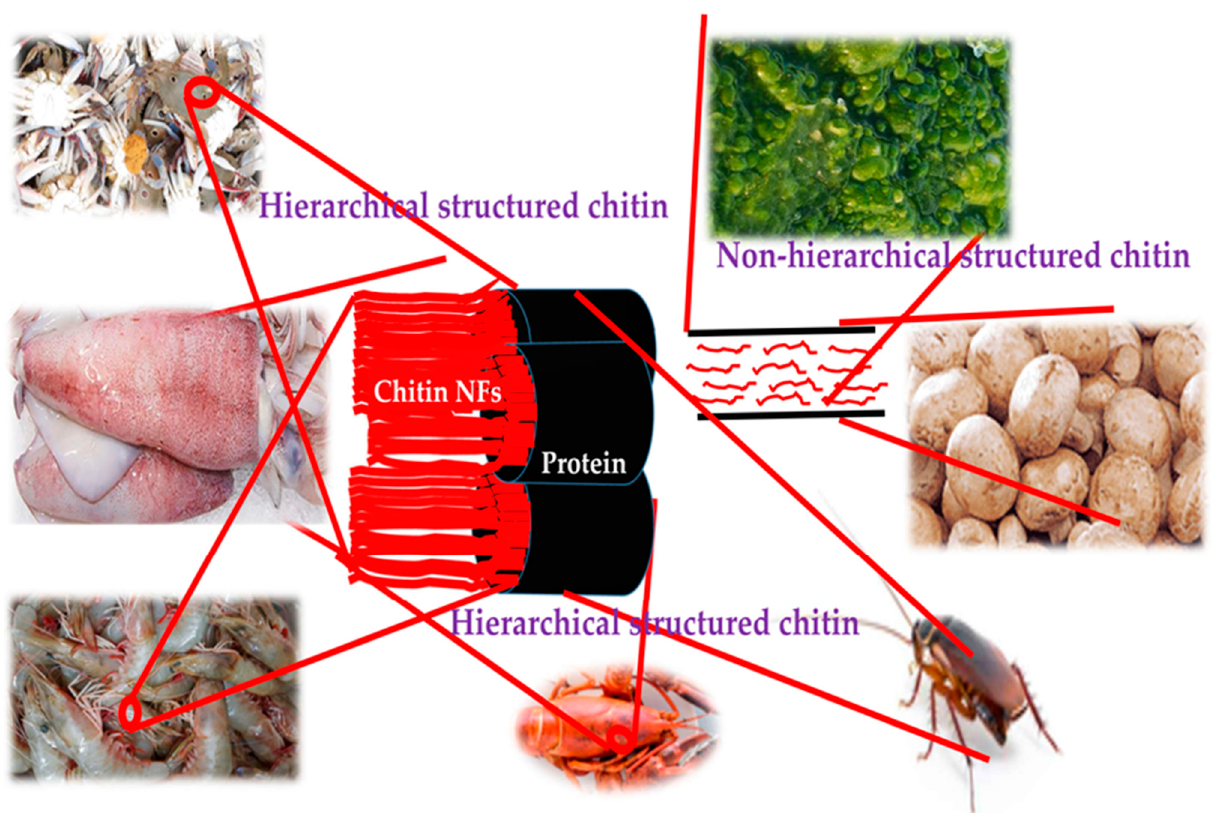
Figure 2. Representatives of natural NFs in chitin sources.